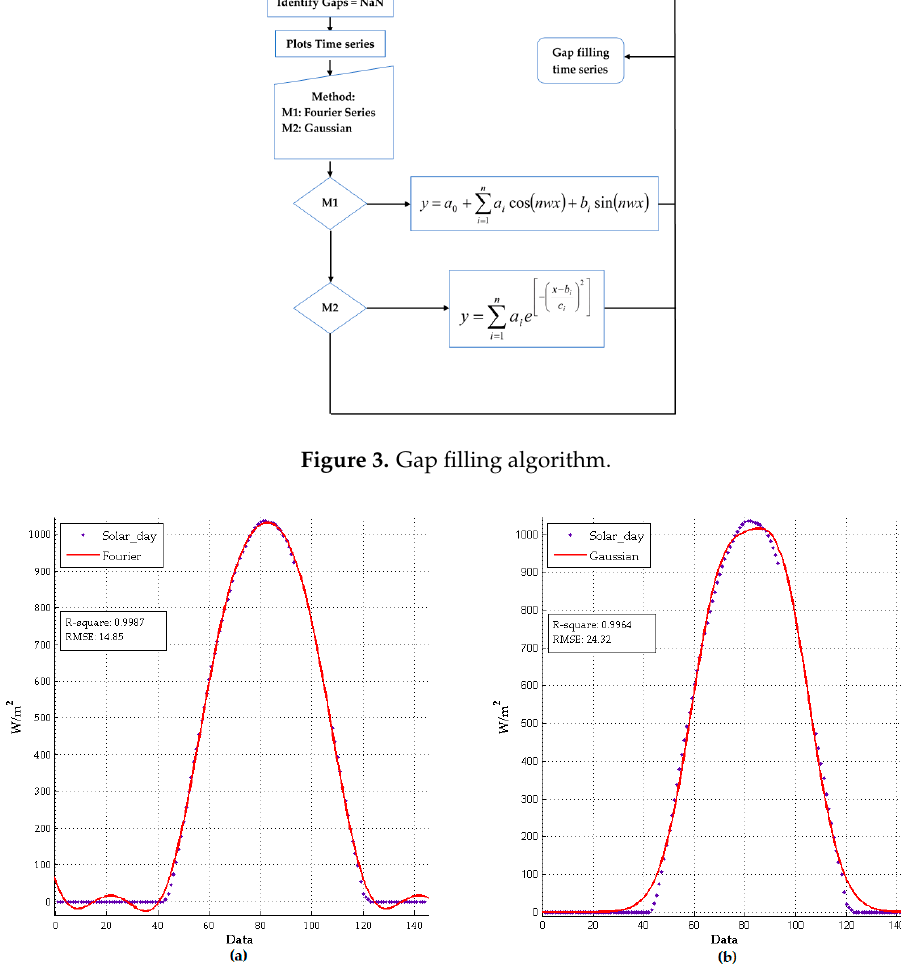
Figure 4. Gap filling. ( a ) A Fourier model and ( b ) A Gaussian model.